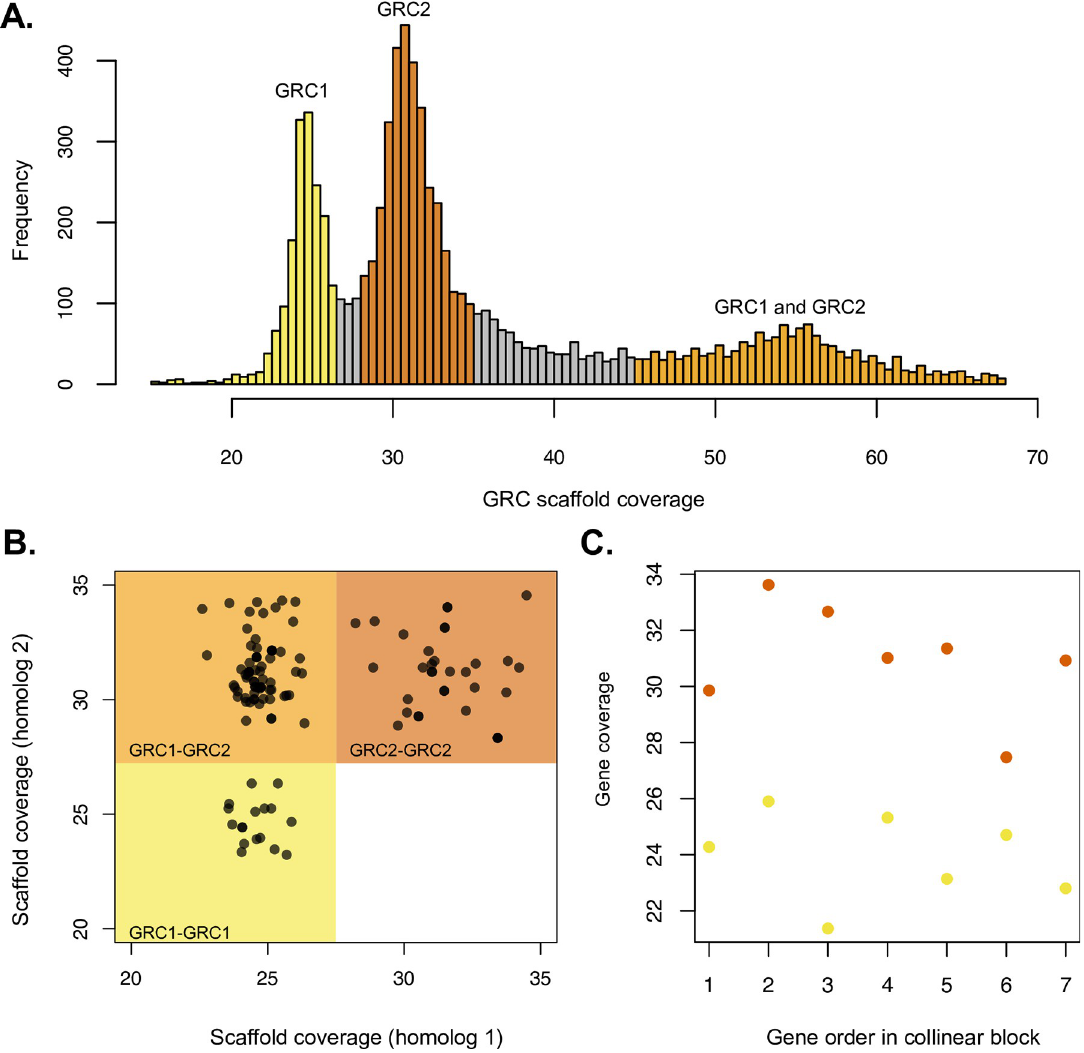
Fig 3. Coverage differences between the 2 divergent GRCs. (A) Histogram showing the coverage of scaffolds (up to 70 × ) assigned to the GRCs based on k-mer and coverage methods. The histogram shows 3 distinct peaks, 1 at 24.7 × (yellow), 1 at 31.0 × (dark orange), which represent the scaffolds belonging to the 2 GRCs (GRC1 and GRC2, respectively). The peak at approximately 55 × (light orange) represents GRC scaffolds that the 2 GRCs have in common. (B) Scaffold coverage of 128 GRC-GRC homologs. Although the majority of homologs have one gene on GRC1 and the other gene on GRC2 (74, in light orange box), a substantial number of homologs also have both genes on GRC1 (20, yellow box), or both genes on GRC2 (34, dark orange box). (C) An example of a GRC-GRC collinear block in which one block is located on GRC1 (yellow) and therefore contains genes with a coverage between 20 × and 27.5 × and the other block is located on GRC2 (dark orange) and therefore contains genes with a coverage from 27.5 × to 35 × . Examples of GRC-GRC collinear blocks in which both blocks are located on the same GRC are in S5 Fig . Location of data used to generate Fig 3A–3C is specified in S1 Table . GRC, germline-restricted